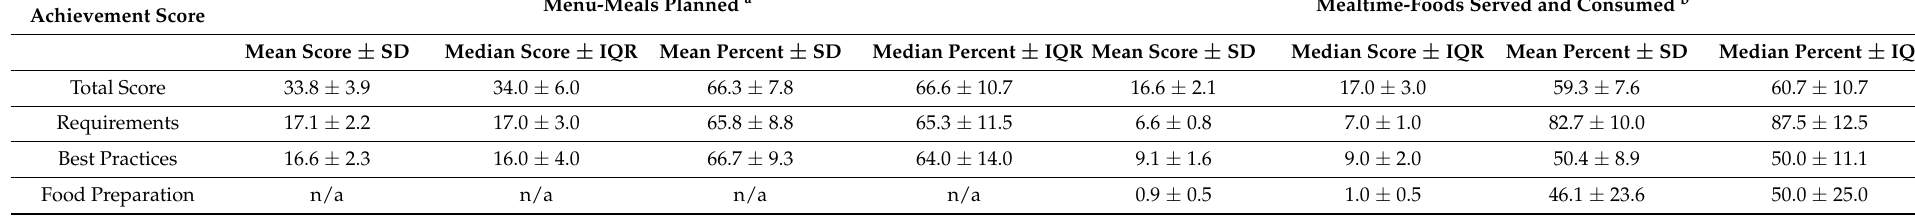
Table 5. Mean Child and Adult Food Program (CACFP) achievement for requirements and recommended practices for menus and foods served and consumed during mealtime in Oklahoma Family Child Care Homes ( n =